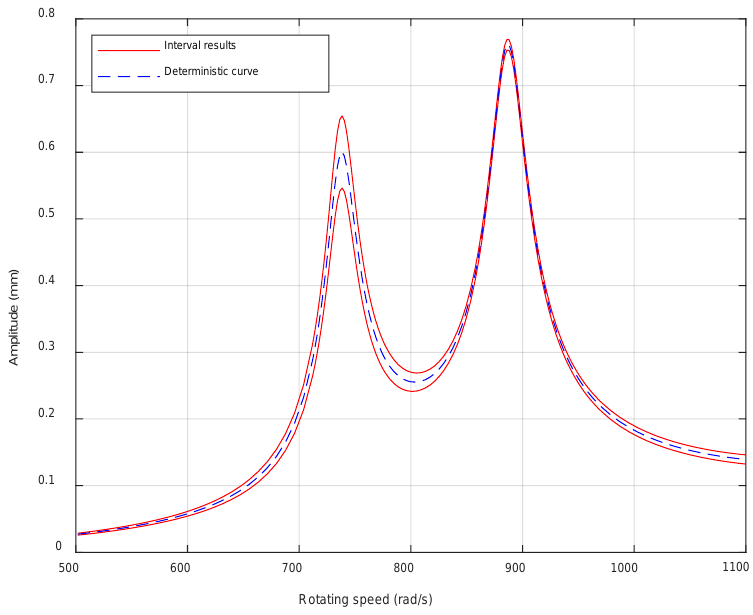
Figure 4. Dynamic response of the LP rotor with uncertain imbalance on the Higher Pressure (HP) rotor.